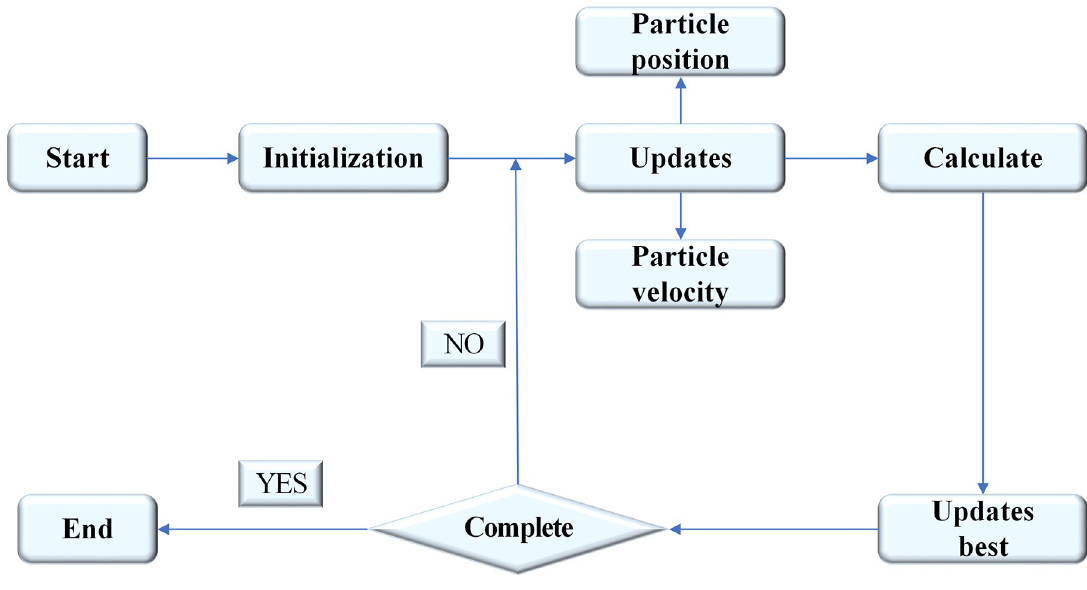
Fig 2. Flow chart of PSO algorithm.